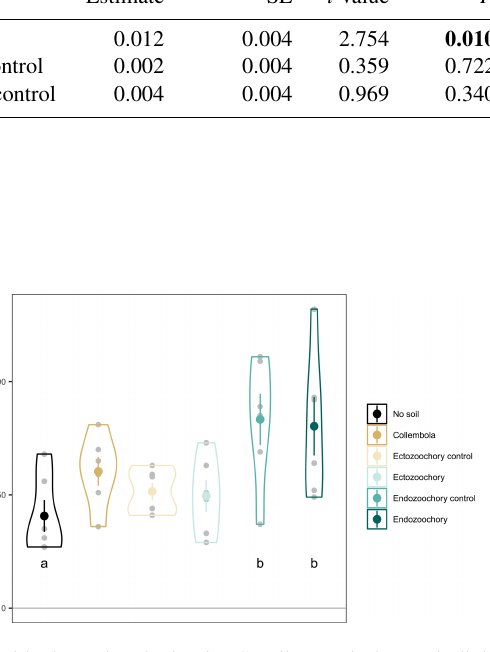
Figure B1. Number of adult Collembola individuals per incubation jar. Small grey circles are individual jar values; large symbols are means; error bars are standard errors of the mean ( n = 6); violin plots denote the shape of the distributions with maximum width proportional to the number of observations. Different black letters denote statistically significant pairwise differences (estimated marginal means pairwise contrasts with Holm adjustment for multiple comparisons, 0.05 <P <